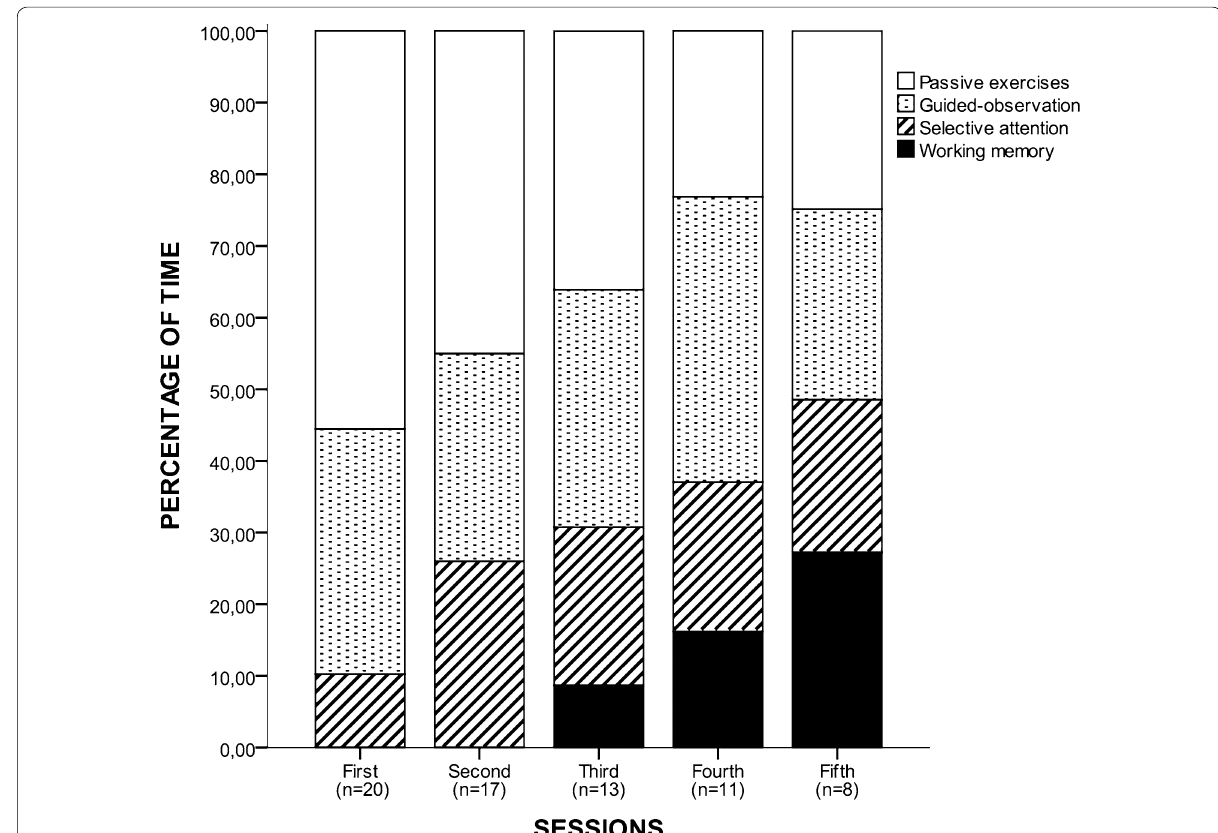
Fig. 3 Time distribution (%) of neurocognitive exercises for each session during the first five sessions. In the first session, passive exercises requiring simple attention and gross motor functions were the most performed exercises. In subsequent sessions, the time spent on passive exercises gradu‑ ally decreased, while the time spent on exercises focusing on selective attention and working memory increased. Guided ‑ observation exercises were well tolerated for patients from the first session. The most complex exercises, focusing on working memory , were only performed from the third ses‑ sion, and the time assigned for these exercises was increased progressively with each session. Note that in the fifth session, equal time was assigned to each type of